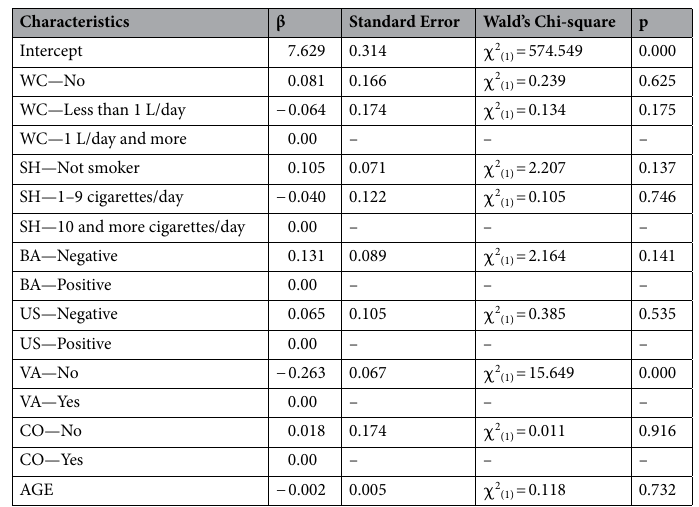
Table 3. Results of the generalized linear model with semen pH (SpH) as response variable. WC wine consumption, SH smoking habit, BA semen bacteriological analysis, US urethral swab, VA varicocele, CO consanguinity.